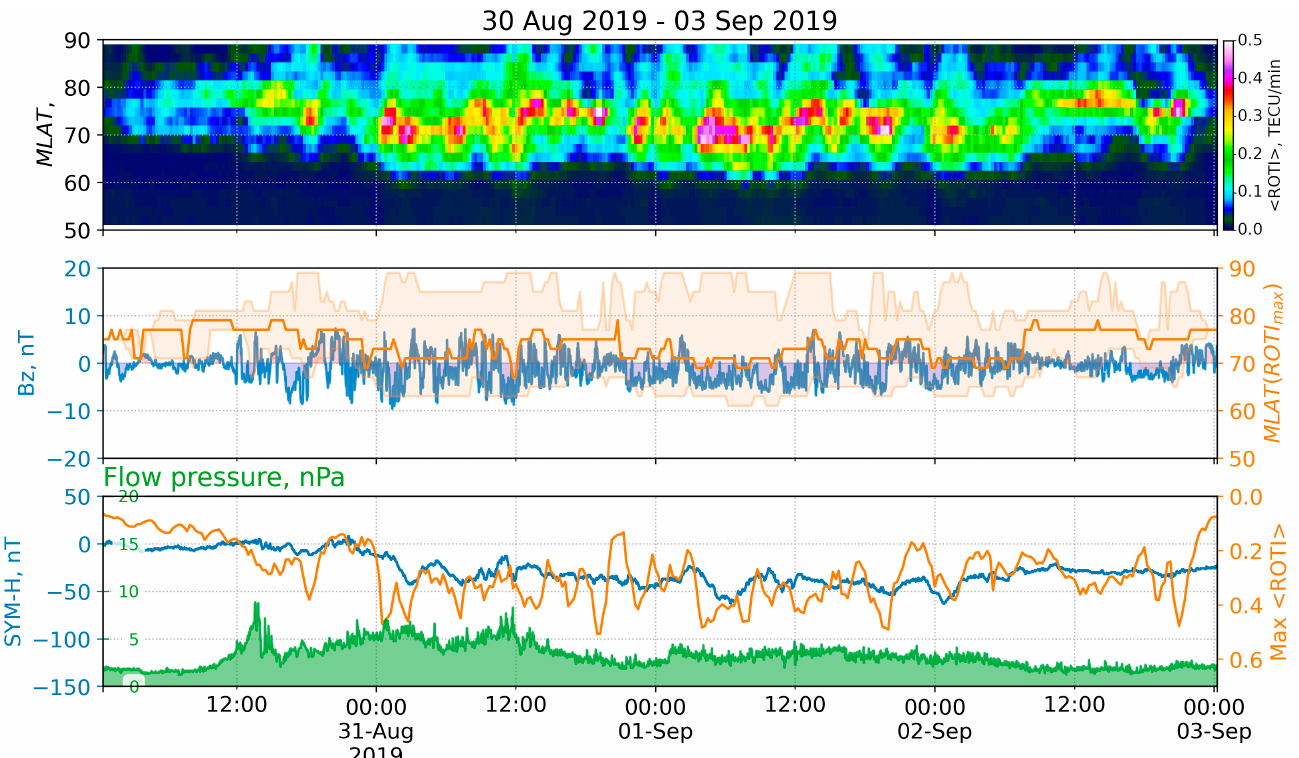
Figure 7. ROTI keogram and space weather parameters for the storm of 31 August–2 September 2019: ( top ) keogram of average ROTI (<ROTI> versus MLAT versus time); ( middle ) IMF Bz ( blue ), MLAT positions of maximum <ROTI> ( orange ), and values exceeding median ROTI at the moment ( orange filling ); ( bottom ) SYM-H index ( blue ), <ROTI> max ( orange ), and flow pressure ( green ).